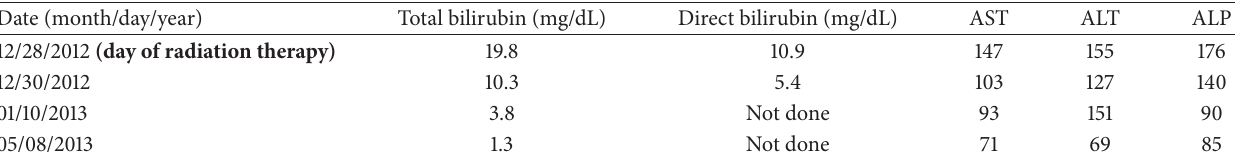
Table 2: LFTs trend table after initiating radiation